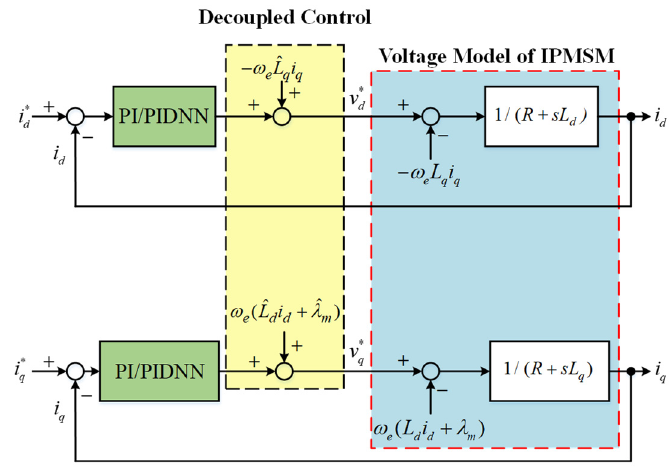
Figure 5. Decoupled control of dq -axis current-loop control.